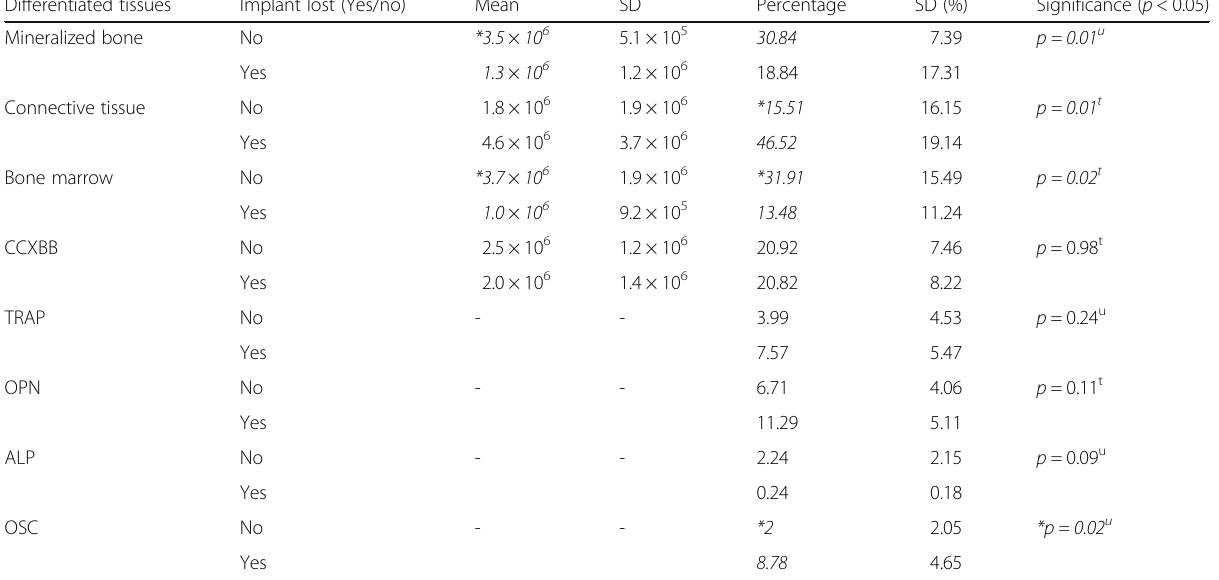
Table 4 Implant loss and tissue characteristics Differentiated